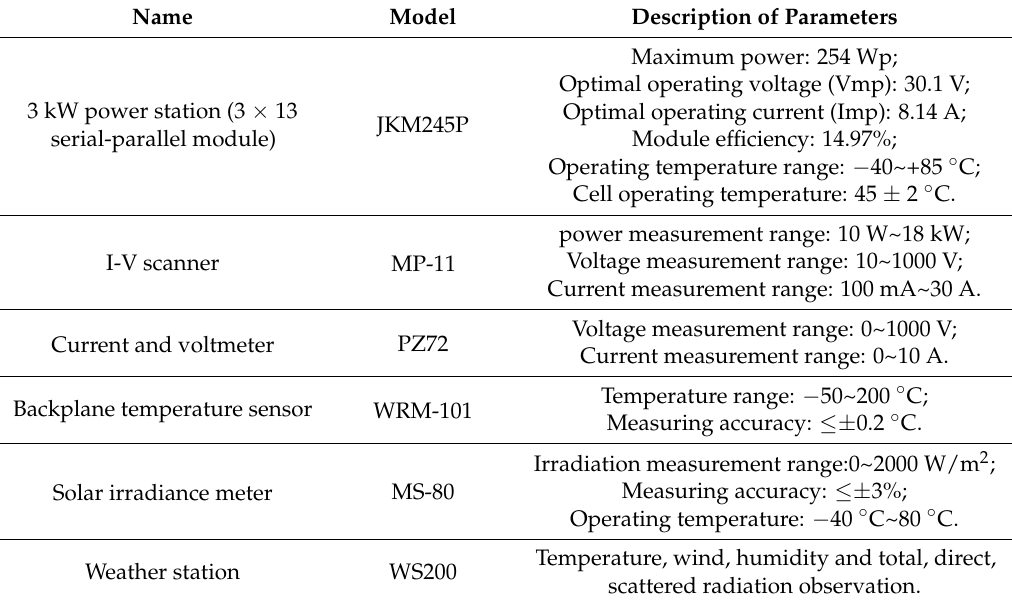
Table 10. The description of the experimental equipment.